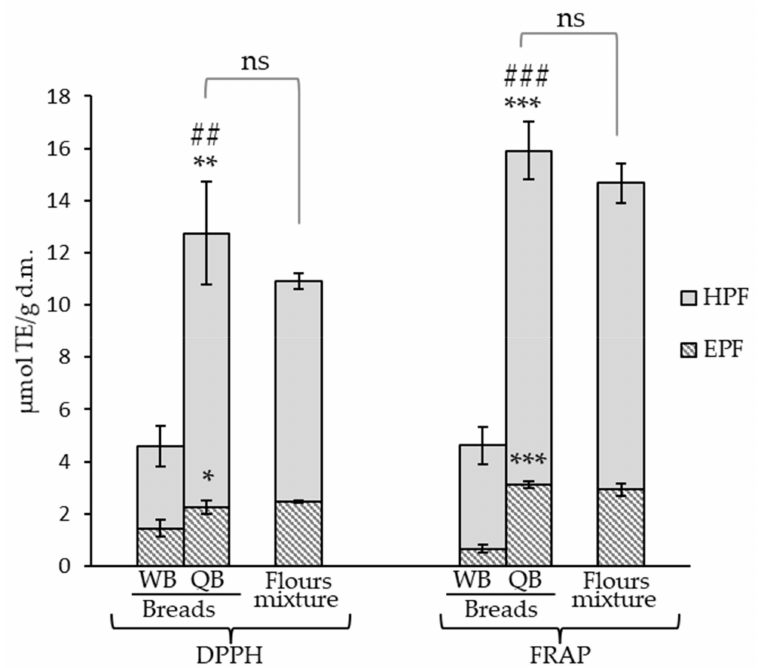
Figure 3. Antioxidant activity of the control bread (WB) and quinoa bread (QB) and effect of the bread-making process on the antioxidant activity of QB (flours mixture vs. QB). *, **, *** denote significances at p < 0.05, p < 0.01, and p < 0.001, respectively, when the extractable (EPF) and hydrolyzable polyphenols fractions (HPF) from QB were compared to the respective control bread (WB) fractions. ## p < 0.01, ### p < 0.001 when EPF + HPF sum was compared. ns: no statistically significant differences when the antioxidant activity of the flours mixture (75% wheat + 25% black quinoa) was compared to QB at the EPF, HPF, and EPF + HPF